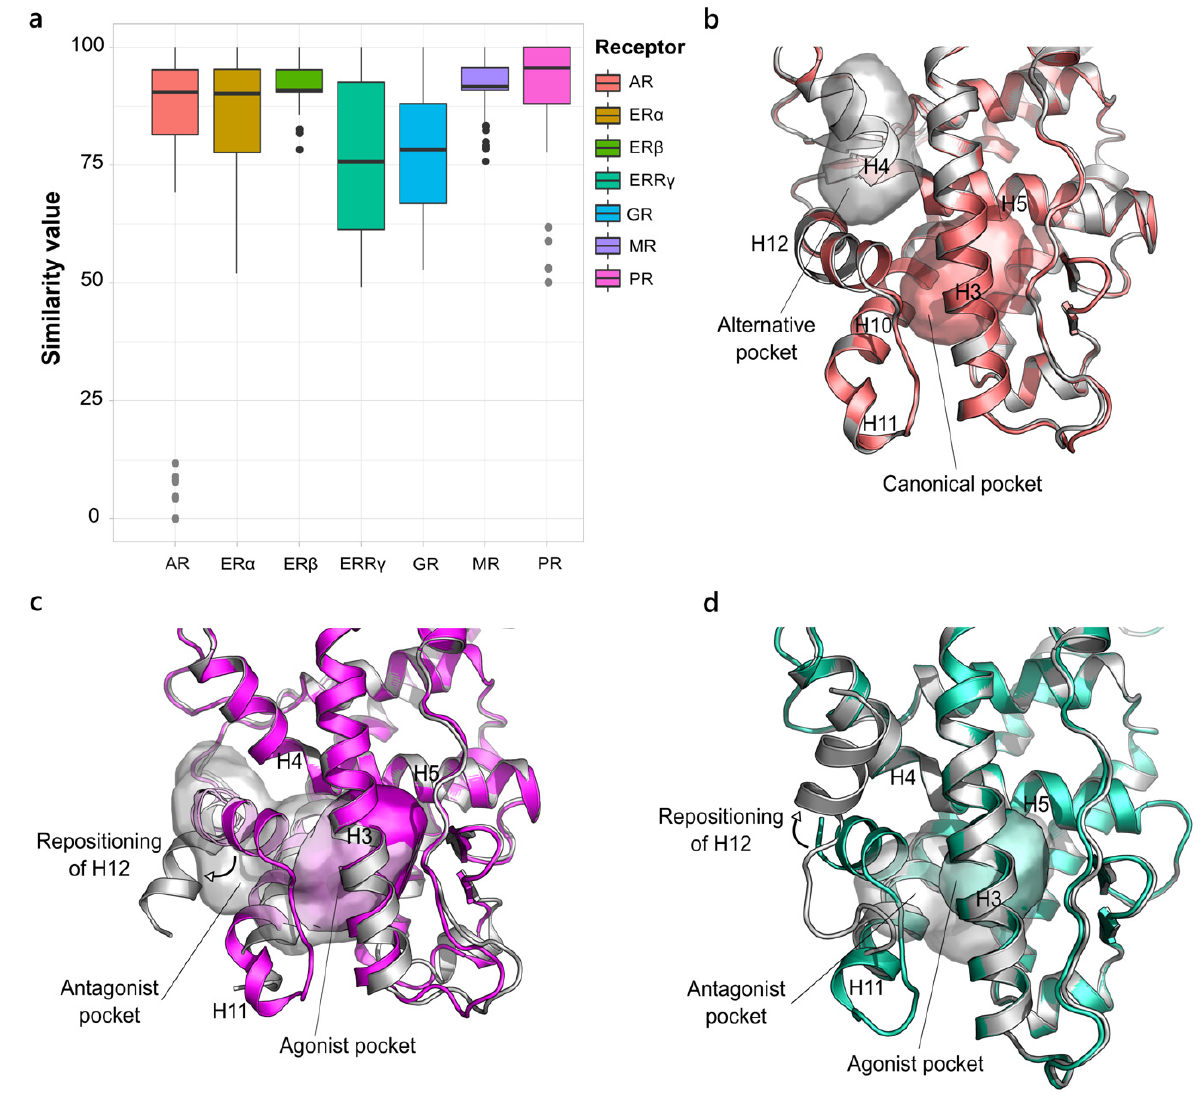
Figure 2. Variability in NR3 family. ( a ) Boxplot representing the structural variability in the LBD binding site in the NR3 family. The outlier points corresponding to non-canonical binding pockets are highlighted in grey. ( b ) Superposition of the canonical active pocket (salmon) and the outlier one (grey) in AR (PDB ID 2PIP). ( c , d ) Superposition of the agonist pocket of PR (magenta, PDB ID 1A28) and ERR γ (green, PDB ID 2P7G) and the antagonist pocket in grey, (PDB IDs 2OVH and 2GPU, respectively). The two pockets are intersected as they share residues in H3, H5 and H10. The rearrangement of H12 from the agonist to the antagonist conformation is